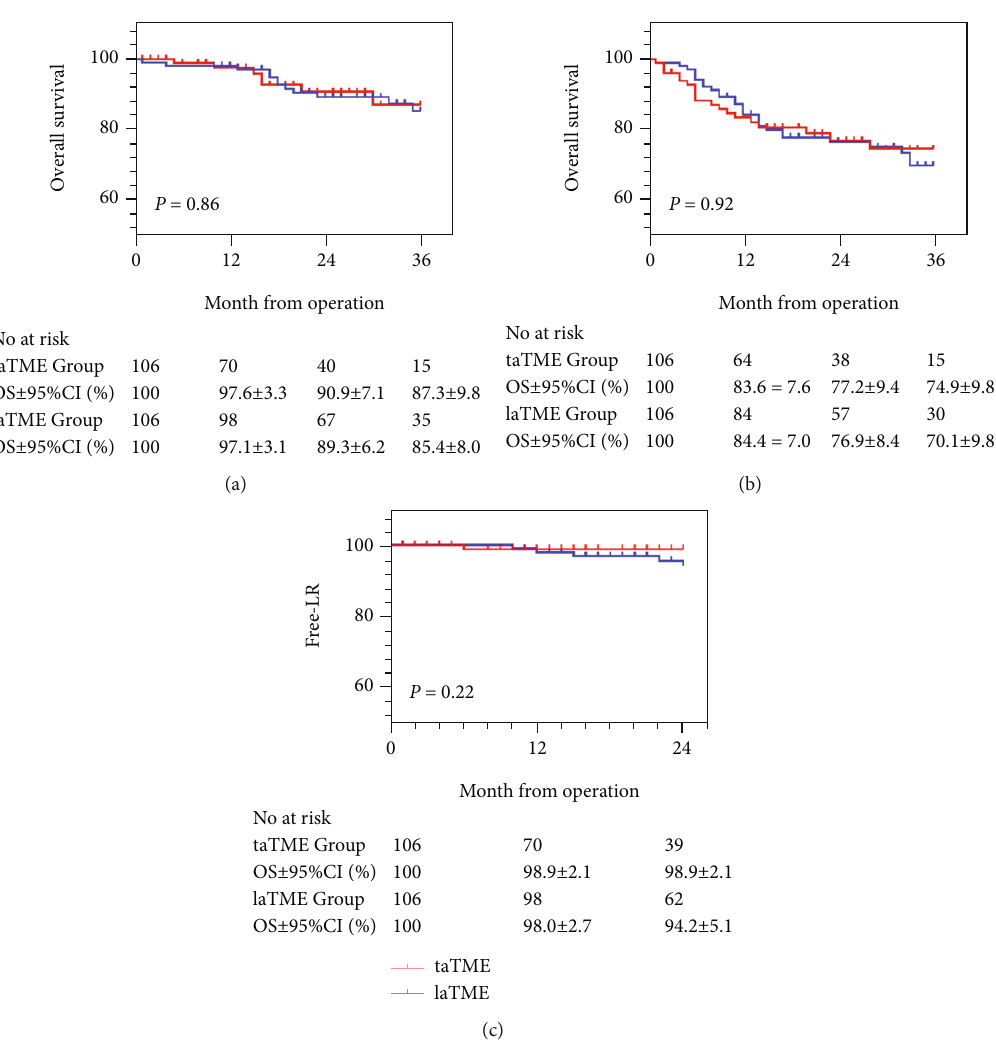
Figure 3: Kaplan – Meier plots of overall survival (a). Kaplan – Meier plots of disease-free survival (b). Kaplan – Meier plots of free-local recurrent